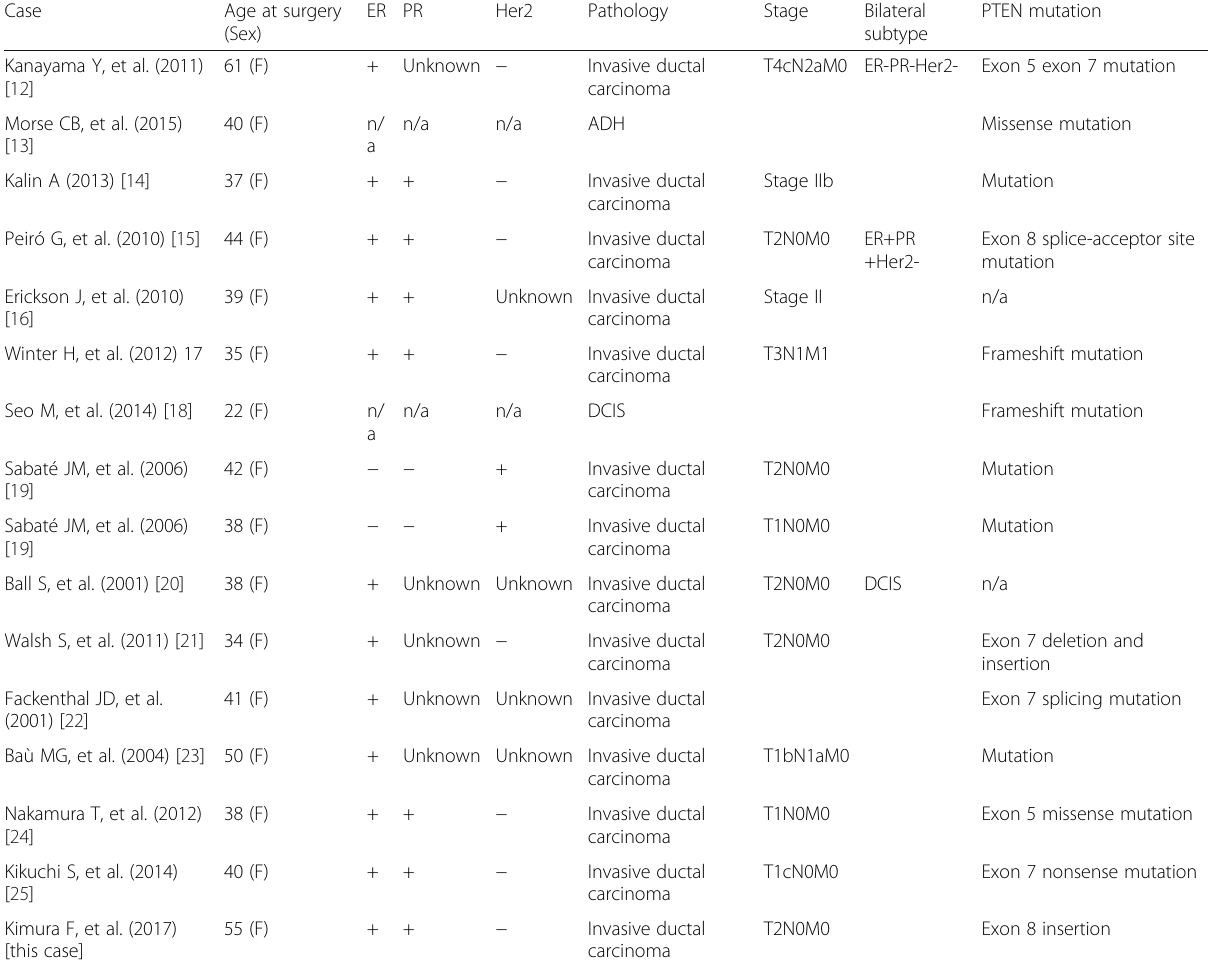
Table 1 Expression of hormone receptor in Cowden disease after